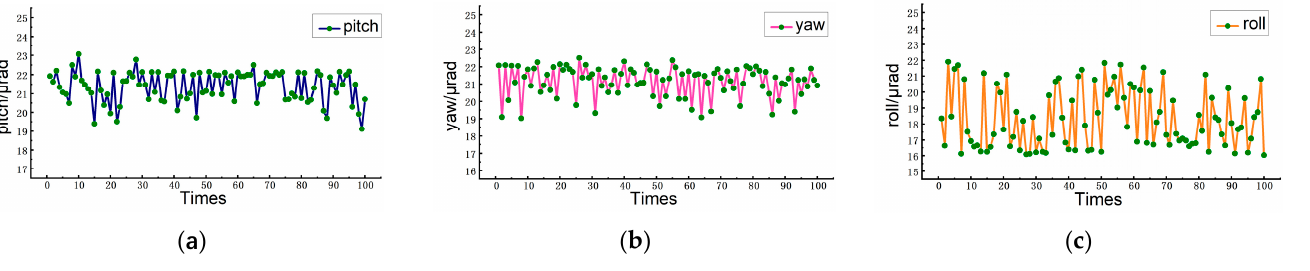
Figure 6. Repeatability experiment results: ( a ) results from pitch loading, ( b ) results from yaw loading, ( c ) results from roll loading.